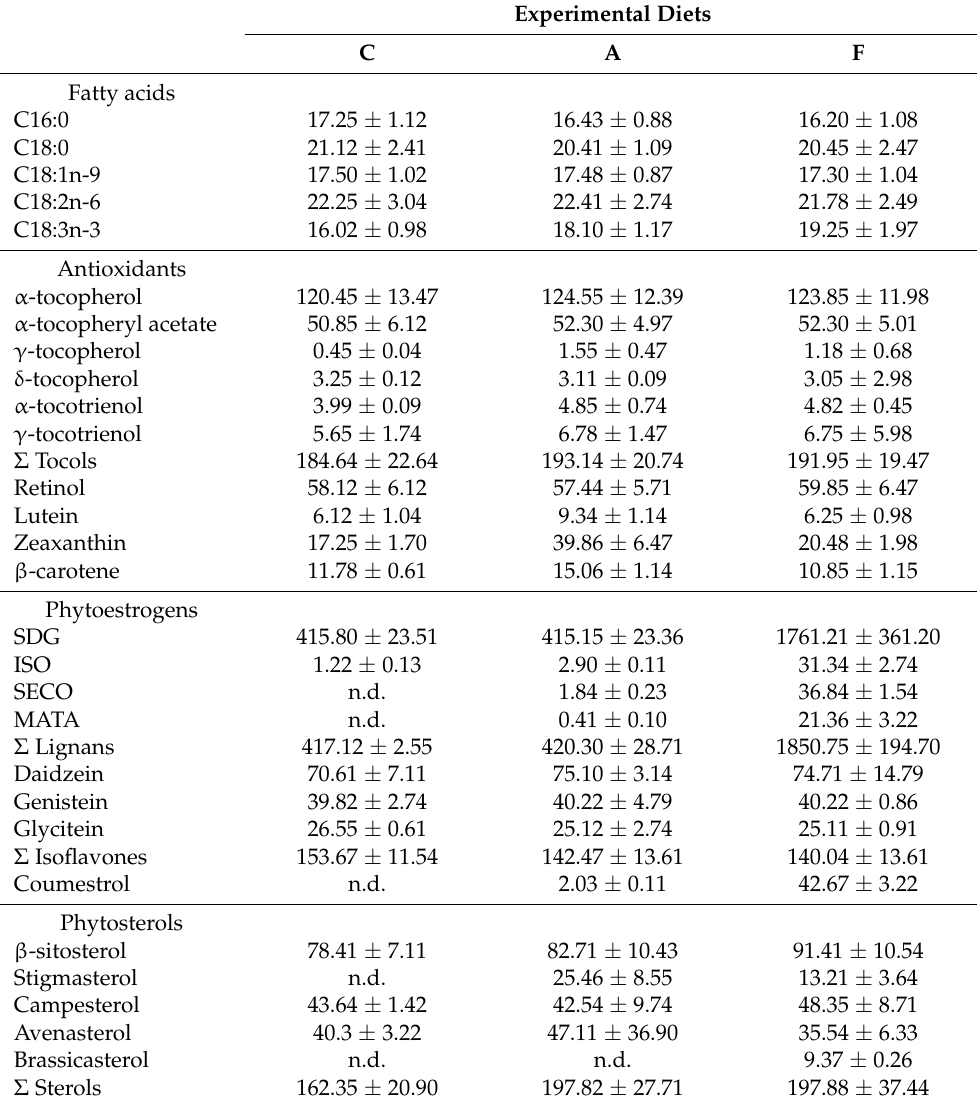
Table 2. Main fatty acids (% total fatty acids), antioxidant compounds (mg/kg f.m.), phytoestrogens (mg/kg f.m.), and phytosterols (mg/kg f.m.) in the control and 3% alfalfa (A) or flax freeze-dried (F) sprouts-enriched diets (mean +